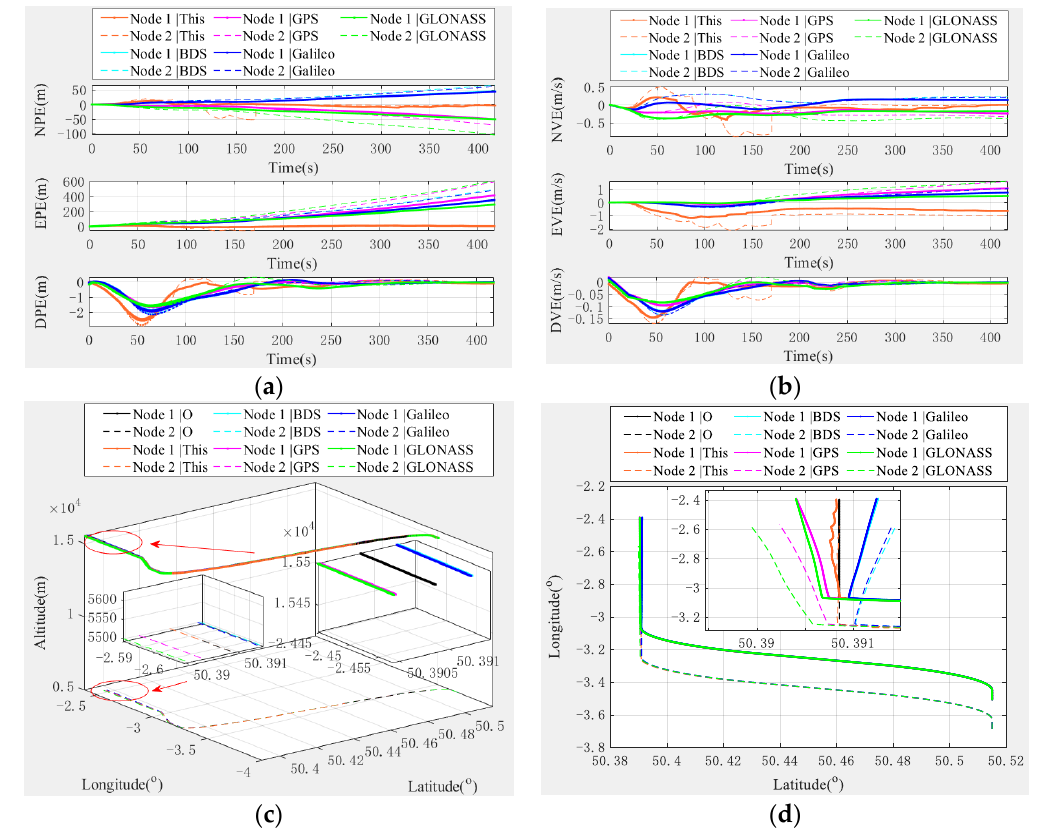
Figure 9. Comparison results with the four major GNSSs: GPS, GLONASS, Galileo, and BDS. ( a ) Position travel curve, ( b ) velocity error curve, ( c ) 3D trajectory error curve, and ( d ) 3D projection error curve.